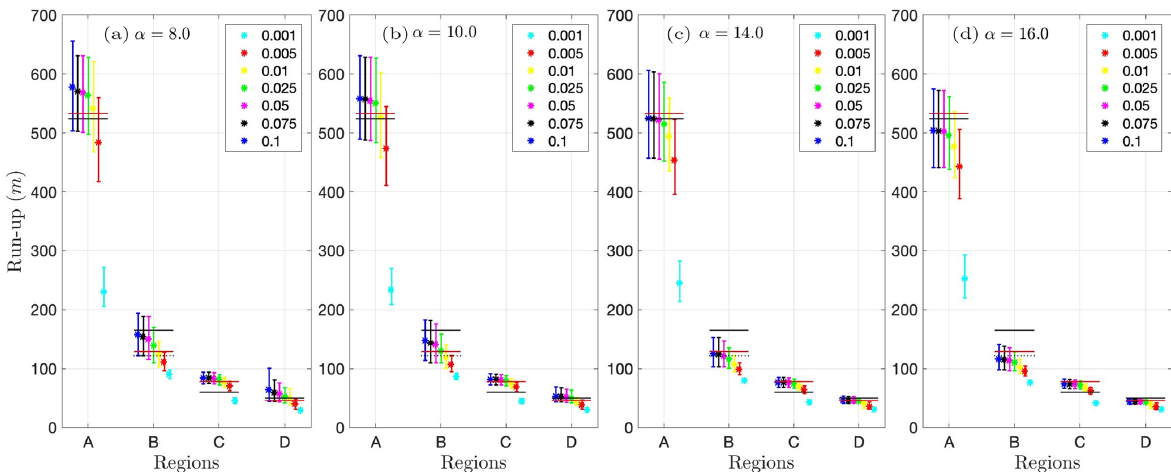
Figure 7. For a fixed value of the Coulomb friction angle, α (in (a) α = 8 ◦ ; (b) α = 10 ◦ ; (c) α = 14 ◦ ; and (d) α = 16 ◦ ), the maximum computed run-up in the four regions defined in Fig. 6 for different values of the friction coefficient, m f (in different colors; see legend), is presented. The vertical bars show the run-up variation for values of r ranging from 0 . 3 to 0 . 6. The horizontal lines (in black) show the reference values for each region: (A) 524m, (B) 165 (solid) and 122m (dashed), (C) higher than 60m, and (D) 50m. In addition, horizontal lines in red show the values for the optimal solution that will be described below.